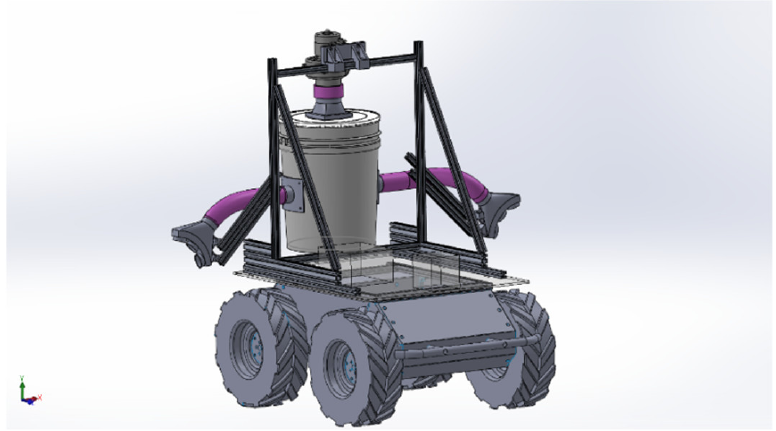
Figure 2. Revised design of cotton-harvesting autonomous platform (CHAP).